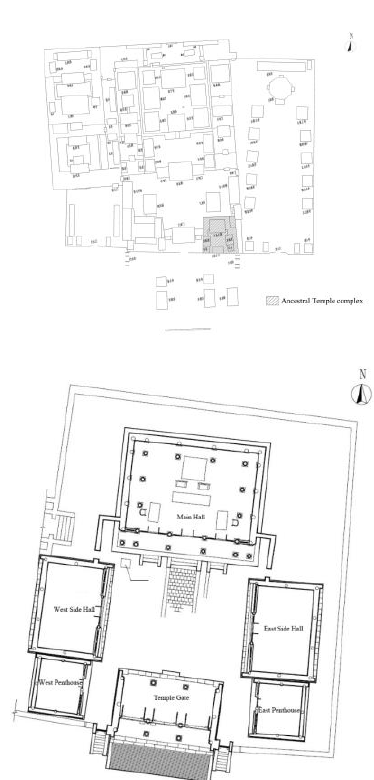
Figure. 3. Site of Ancestral Temple Complex in Mukden